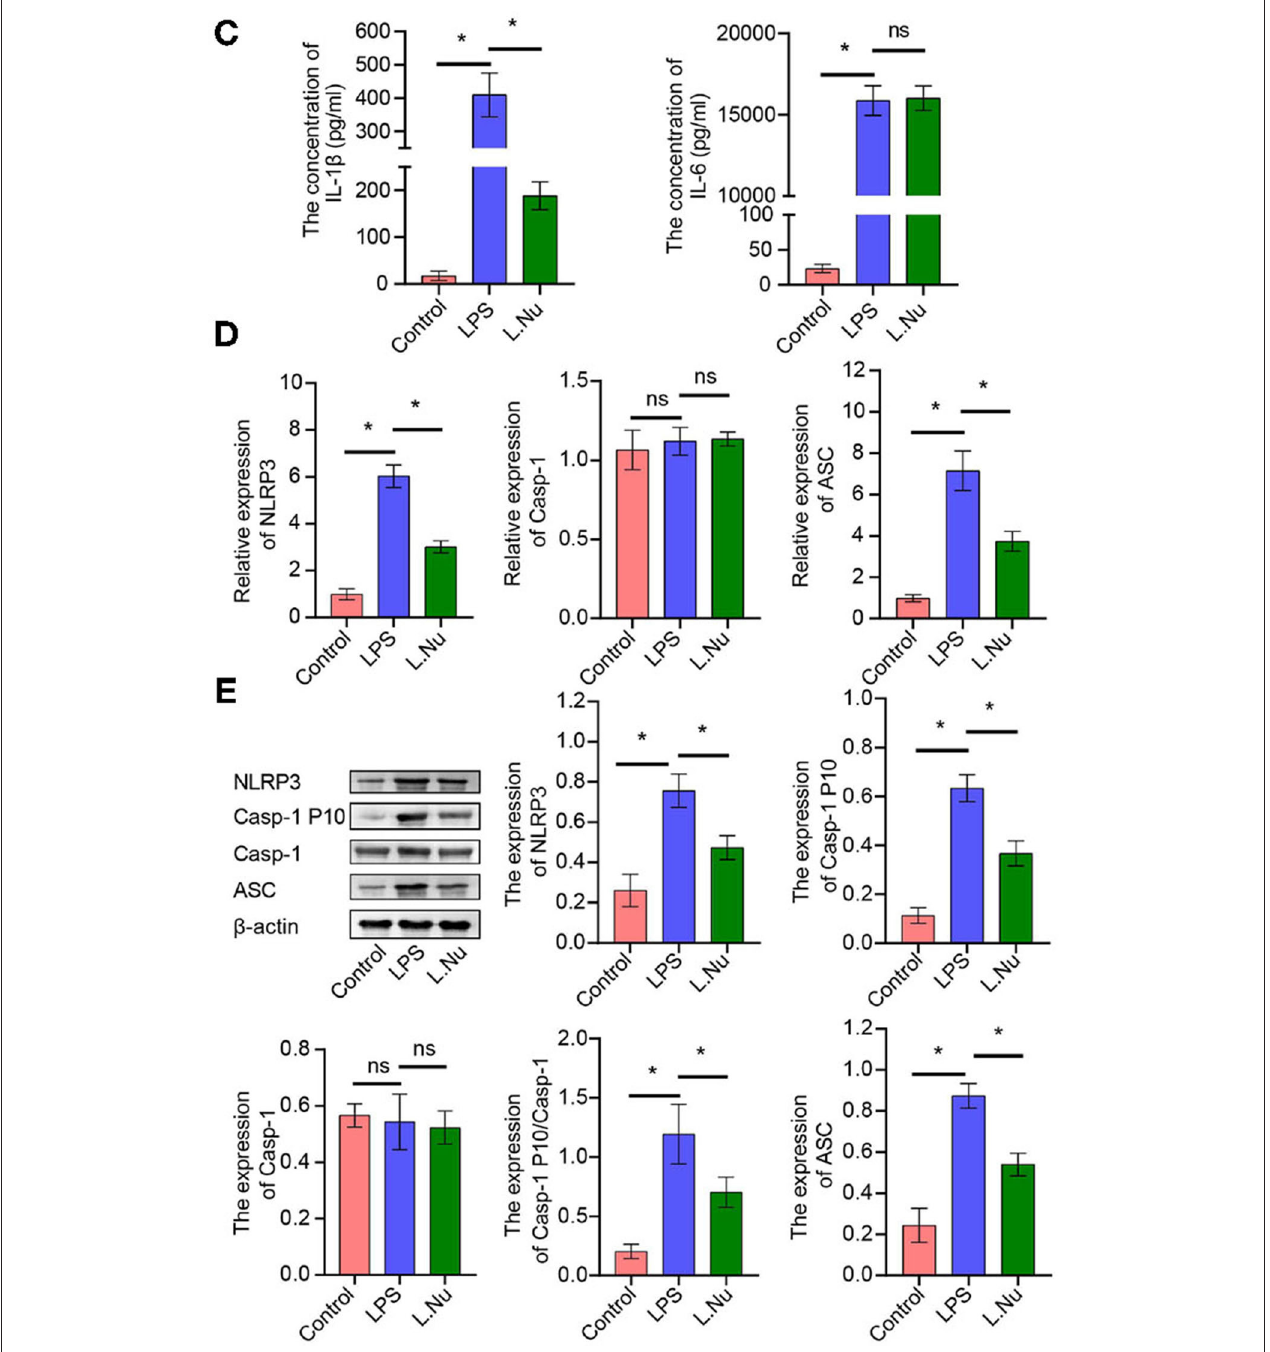
FIGURE 3 | NU9056 might inhibit microglia activation and inflammation by inhibiting the NLRP3 inflammatory pathway in vivo. (A,B) The expression level of Iba-1 and NLRP3 in hippocampal microglia of mice were detected using IF; (C) the concentrations of IL-1 β and IL-6 in the serum of mice were tested using ELISA; (D,E) genes or proteins expression levels of NLRP3, ASC, Casp-1, and Casp-1 P10 in the hippocampus of mice were analyzed by RT-qPCR or Western blot. * P < 0.05; ns, not significant.